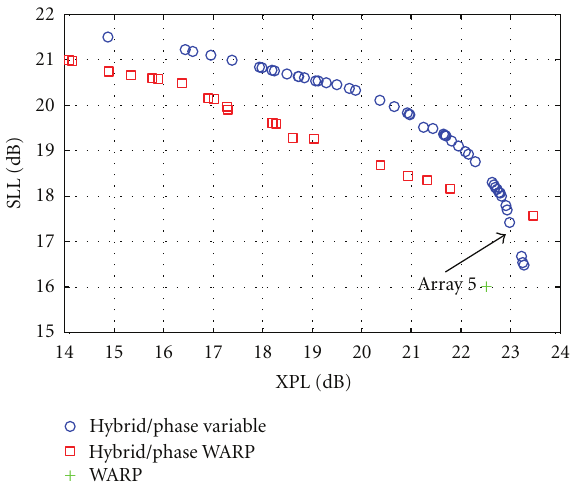
Figure 6: Resulted Pareto front of hybrid variable phase compared to WARP with assuming isolated elements.